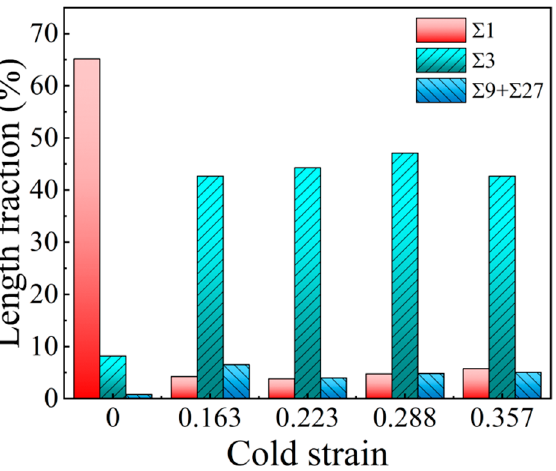
Figure 11. Variations of length fractions of Σ 1 grain boundaries and Σ 3 n twin boundaries with cold strain.